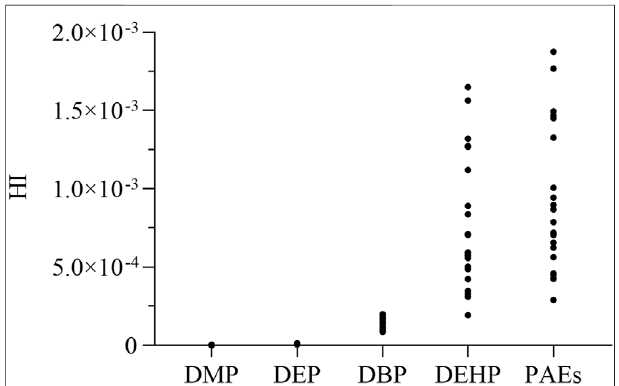
FIGURE 6 | The hazard index (HI) was calculated to assess the noncancer risk posed by the intake of phthalate acid esters (PAEs) in ginseng roots. Black dots represent the HI value of the target PAEs per ginseng